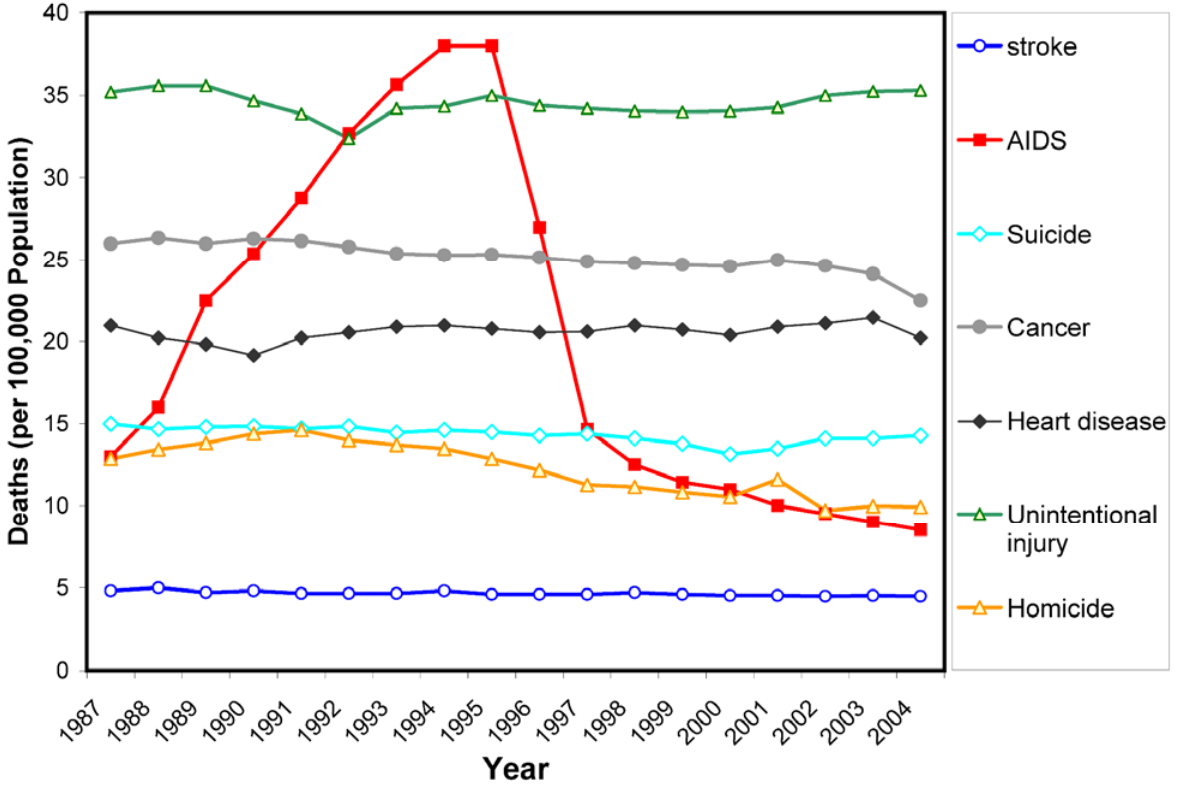
Figure 1. Trends in annual rates of death due to 7 leading causes among persons 25-44 years old in the United States during period 1987-2004. Dramatic decrease in the rate of death due to AIDS coincides with the introduction of HIV protease inhibitors (source: National Vital Statistics, Centers for Disease Control and Prevention,